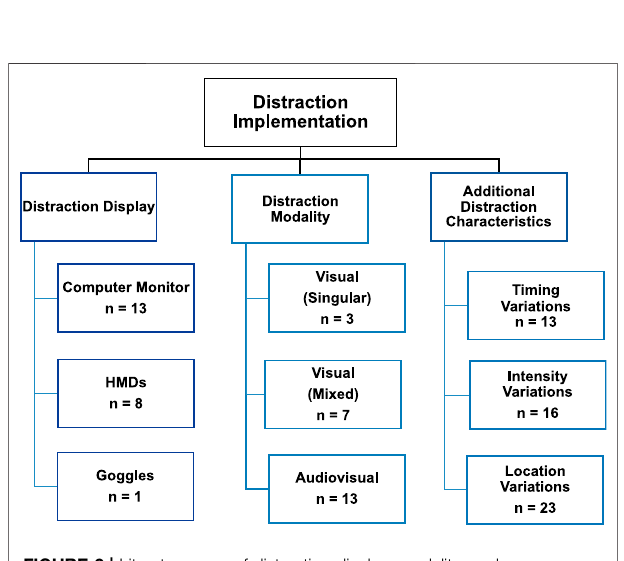
FIGURE 2 | Literature map of distraction display, modality, and additional characteristics across all clinical populations.